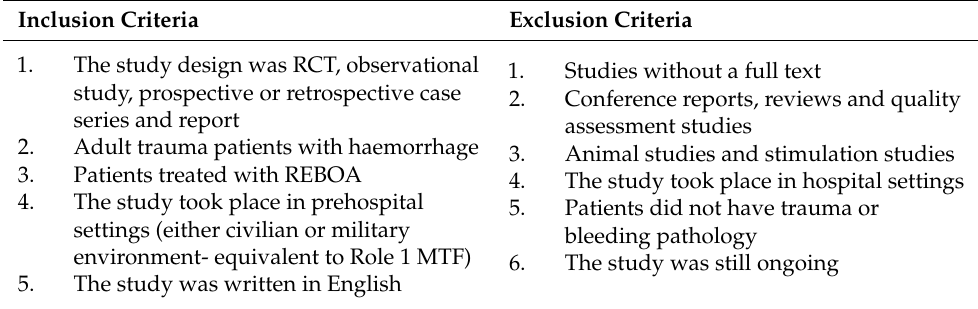
Table 2. Inclusion and exclusion